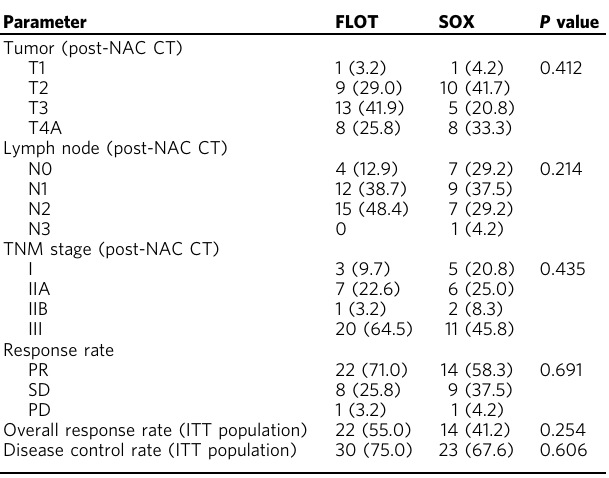
Table 4 Clinicopathological results of two groups.